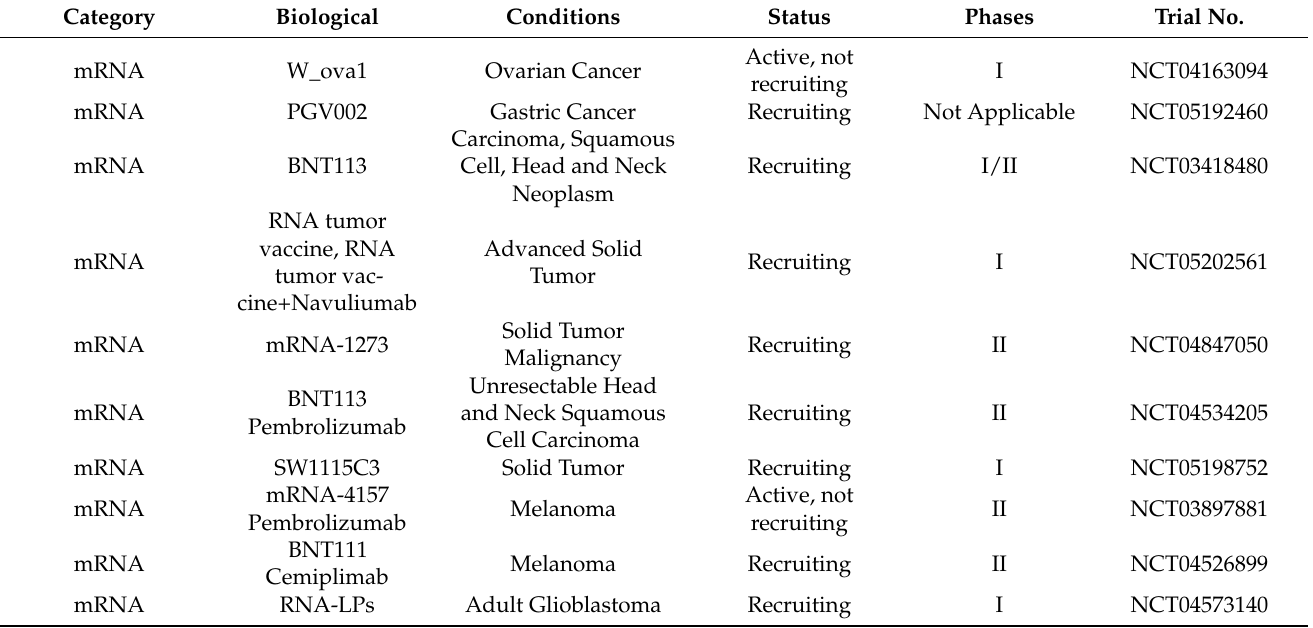
Table 3. RNA-based cancer vaccines in clinical